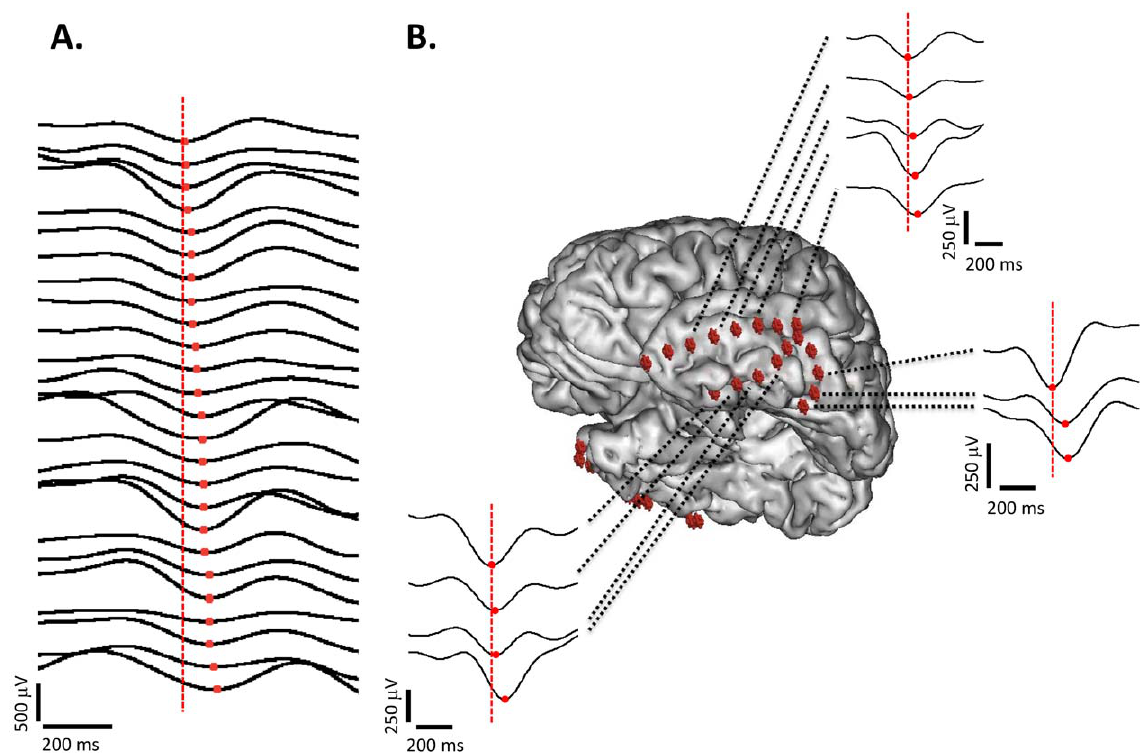
Figure 4. Propagation of the slow waves. A. Filtered (0.1–4 Hz) signals of intracranial EEG contacts of one global slow wave event ordered as a function of the position of the minimum (red dots). The vertical dashed line marks the position of the minimum of the first detection. B. Three examples of local propagation in the temporal lobe. Each example corresponds to a different slow wave event. In all cases the signals are linked to the position of the recording contacts in the brain, represented by red cubes.